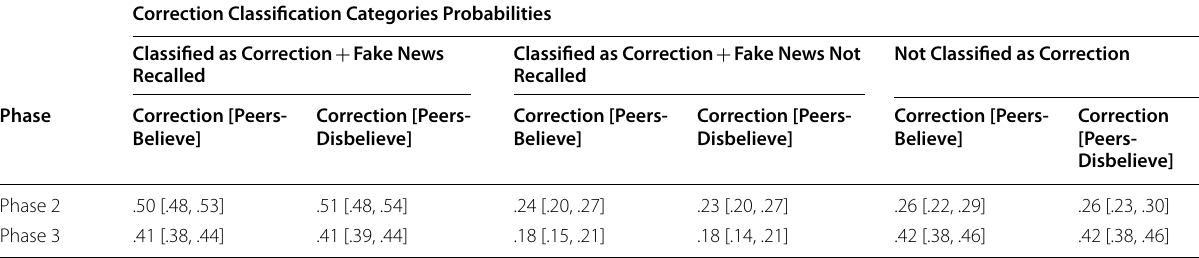
95% confidence intervals are displayed in brackets. The classifications above all pertain to Correction headline types. Classified as Correction were instances when headlines were classified as corrections and participants could recall the fake news details. Classified as Correction were instances when headlines were classified as corrections, but participants could not recall the fake news details. Not Classified as Correction were instances when headlines were not classified as corrections